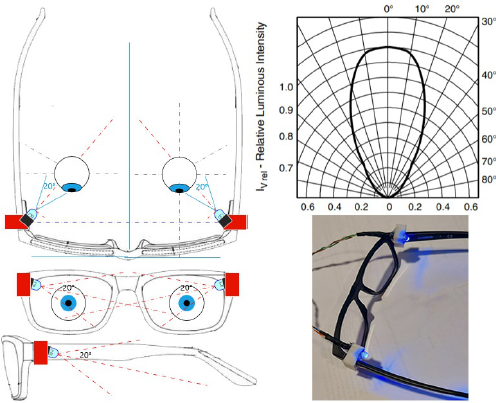
Figure 11. Actuator views, luminous intensity graph, and actuator